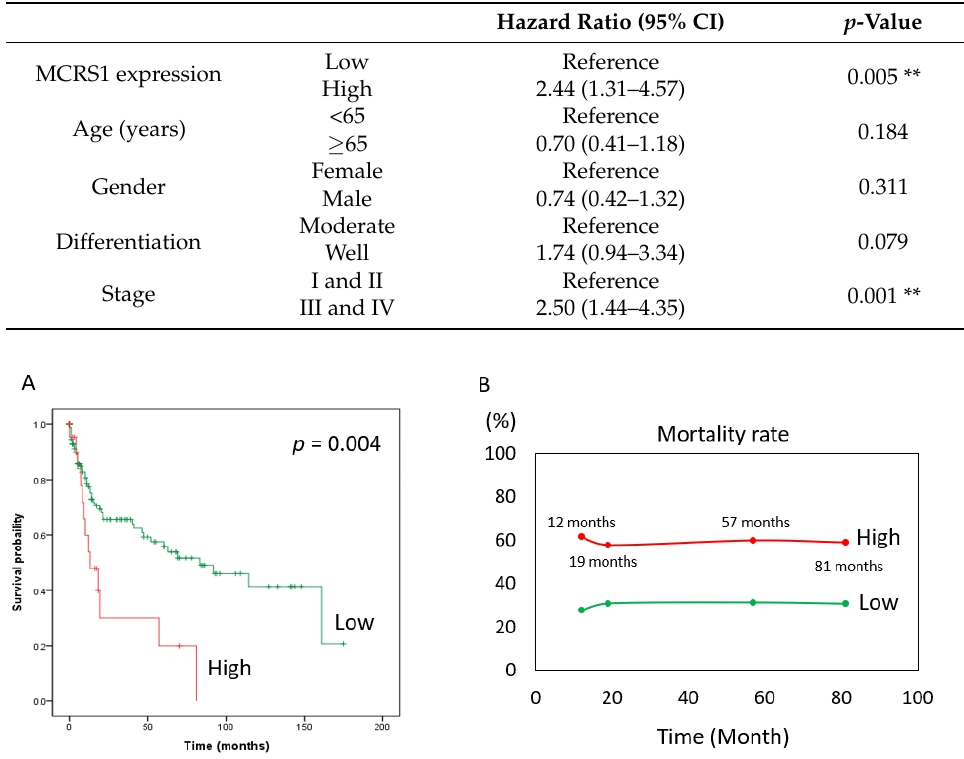
Figure 2. Kaplan–Meier plot of MCRS1. ( A ) The green line indicates low MCRS1 expression (N = 159). The red line indicates high expression of MCRS1 (N = 22). ( p -value = 0.004) ( B ) Mortality at 12 months, 19 months, 57 months, and 81 months. Table 4. Hazard ratios of MCSR1. (** p -Value < 0.01)